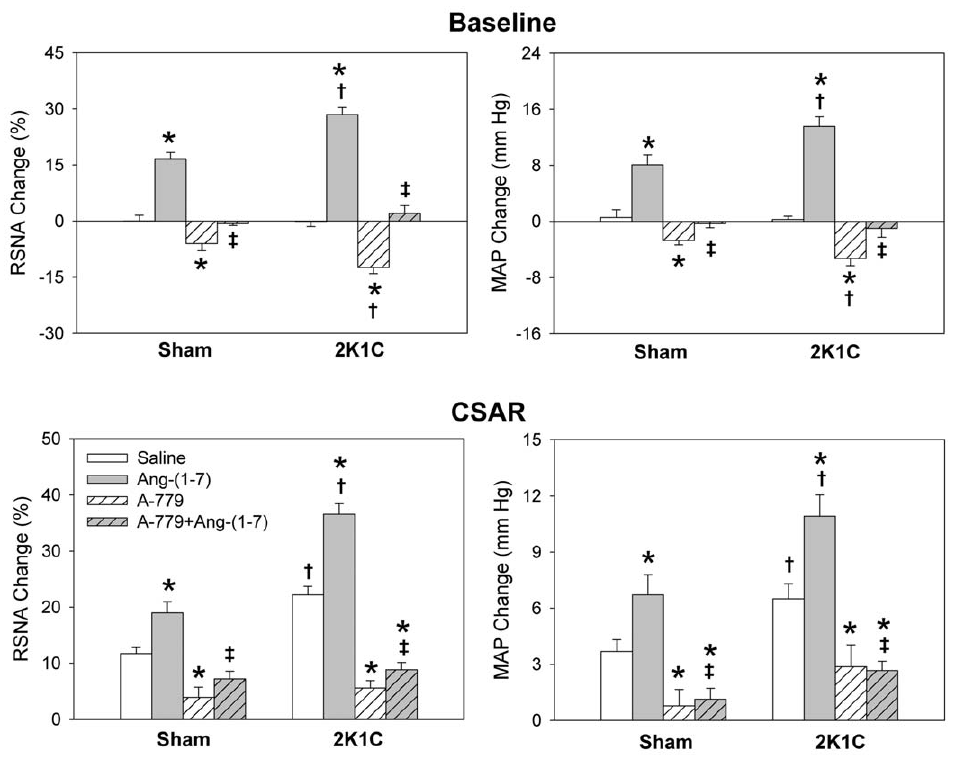
Figure 3. Effects of PVN microinjection of saline, Ang-(1–7) (3 nmol), A-779 (3 nmol), A-779 + Ang-(1–7) on the baseline RSNA and MAP and CSAR. The CSAR was evaluated by the RSNA and MAP responses to epicardial application of capsaicin (1 nmol). Values are mean 6 SE. * P , 0.05 compared with saline. { P , 0.05 compared with Sham. { P , 0.05 compared with Ang-(1–7) alone. n=6 for each group.